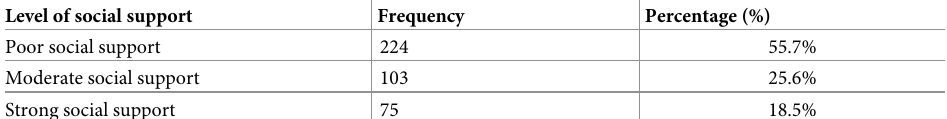
Table 3. Level of social support of diabetic patients at the outpatient clinic of public hospitals, Bale Zone, 2021 (n = 402).